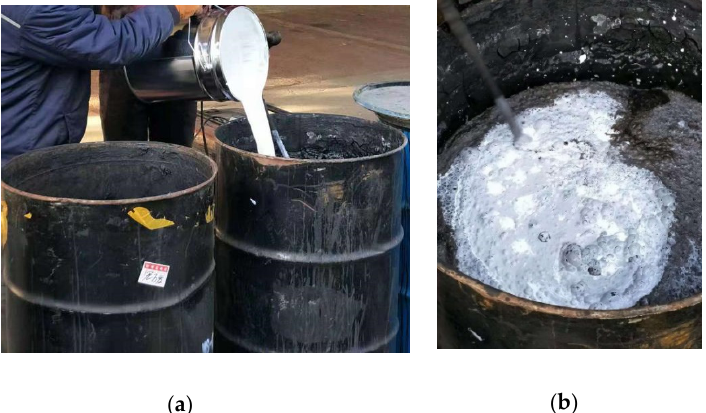
Figure 8. Preparation of functional Sand-fog seal: ( a ) adding; ( b ) mixing.